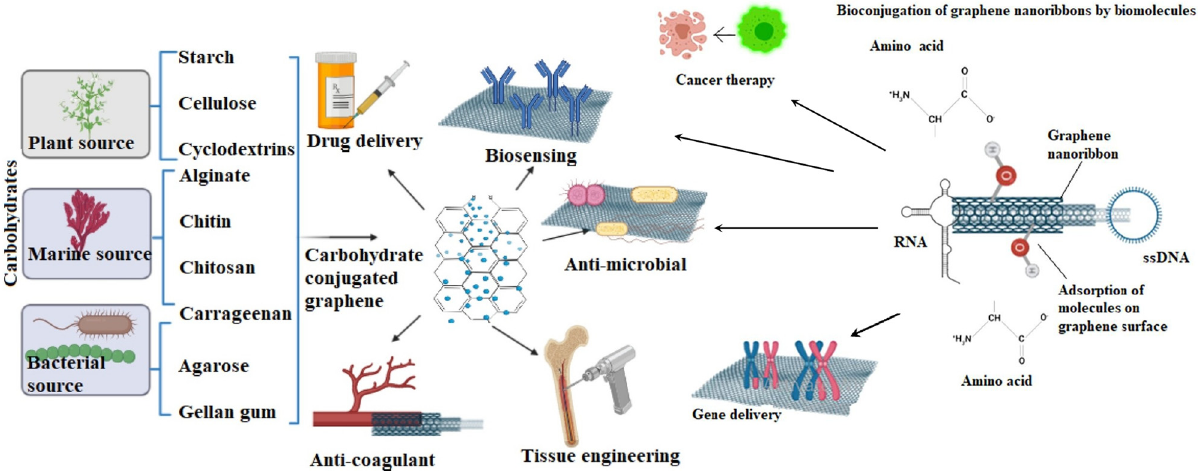
Figure 7: Biomedical applications of carbohydrate – graphene - based nanocomposites [ 72,79 ]